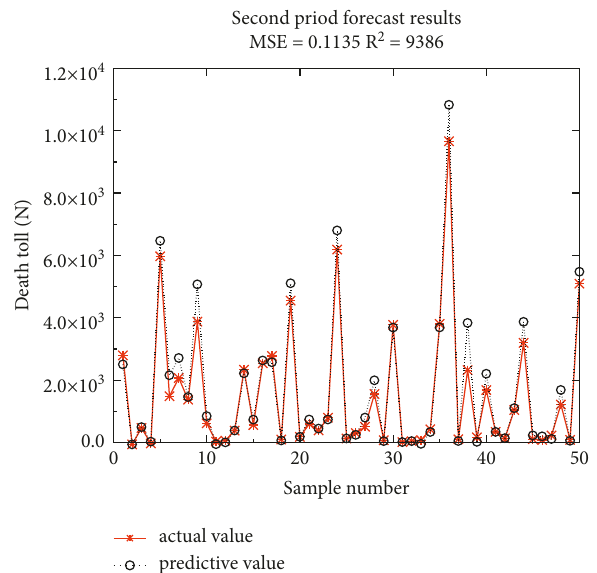
Figure 6: Prediction results of the second period.